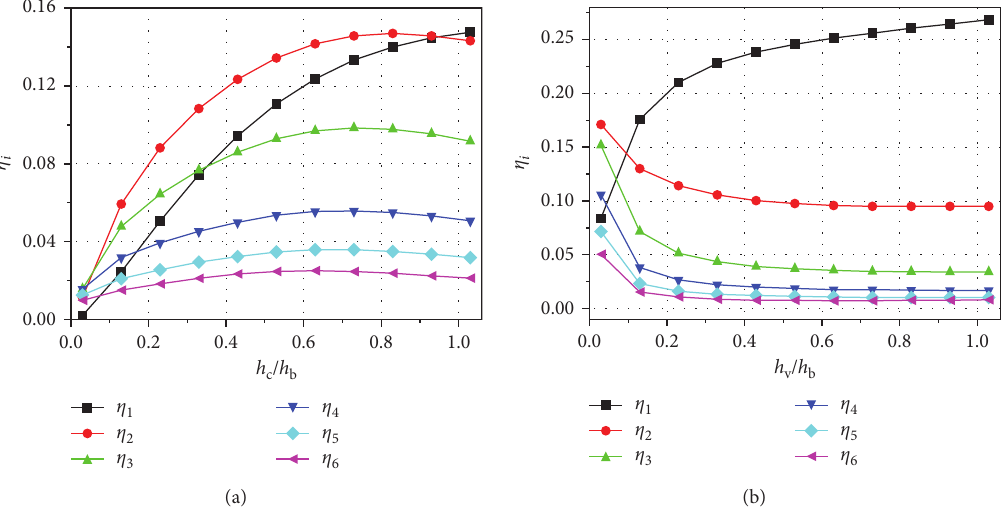
Figure 4: The parameter effects on the first six modal loss factors of structure 1. (a) h